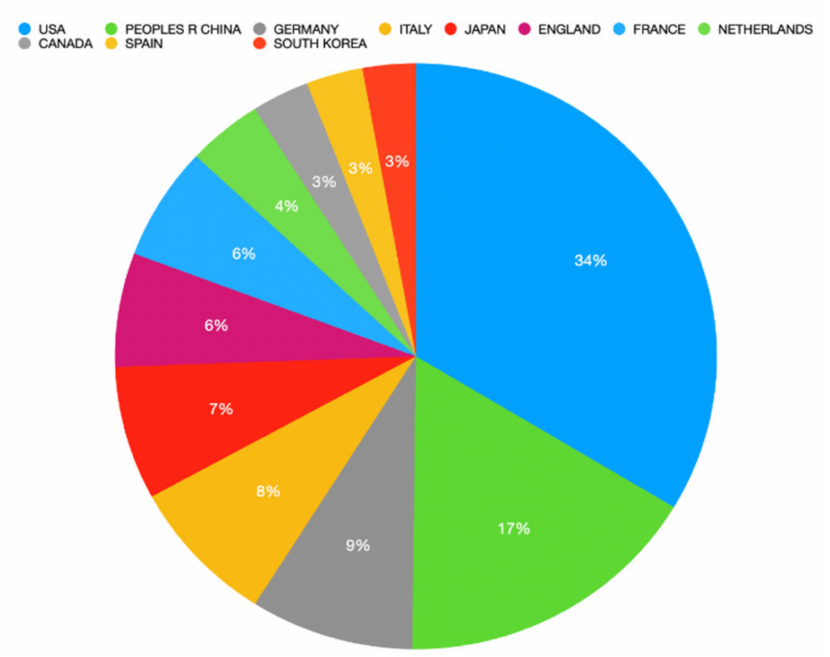
Figure 3. Top 10 countries regarding the number of publications related to immunotherapy research and colorectal cancer.